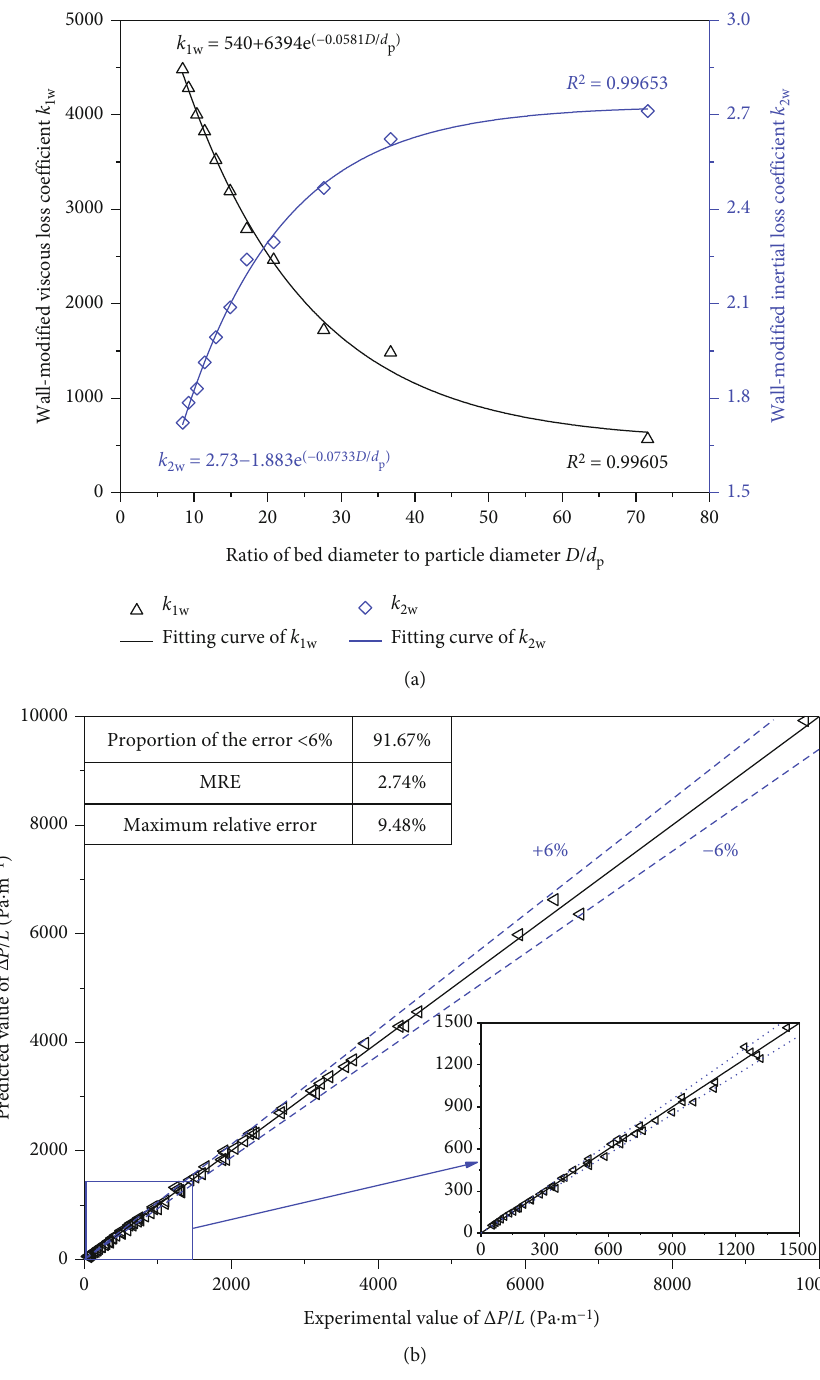
Figure 8: Analysis of the wall-modi fi ed correlation of the pressure drop: (a) relationship between k between the experimental value and the predicted value of Δ P / L